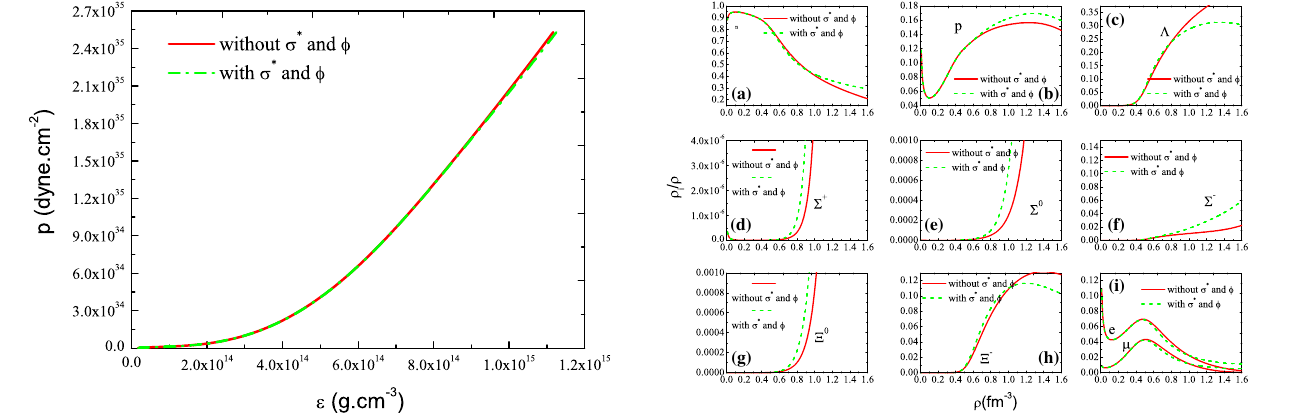
Fig. 5 The pressure p of the PNS as a function of the energy density ε . The thick solid red curves represent the case where the hyperon interaction is not considered, while the green virtual curves represent the case where the hyperon interaction is considered